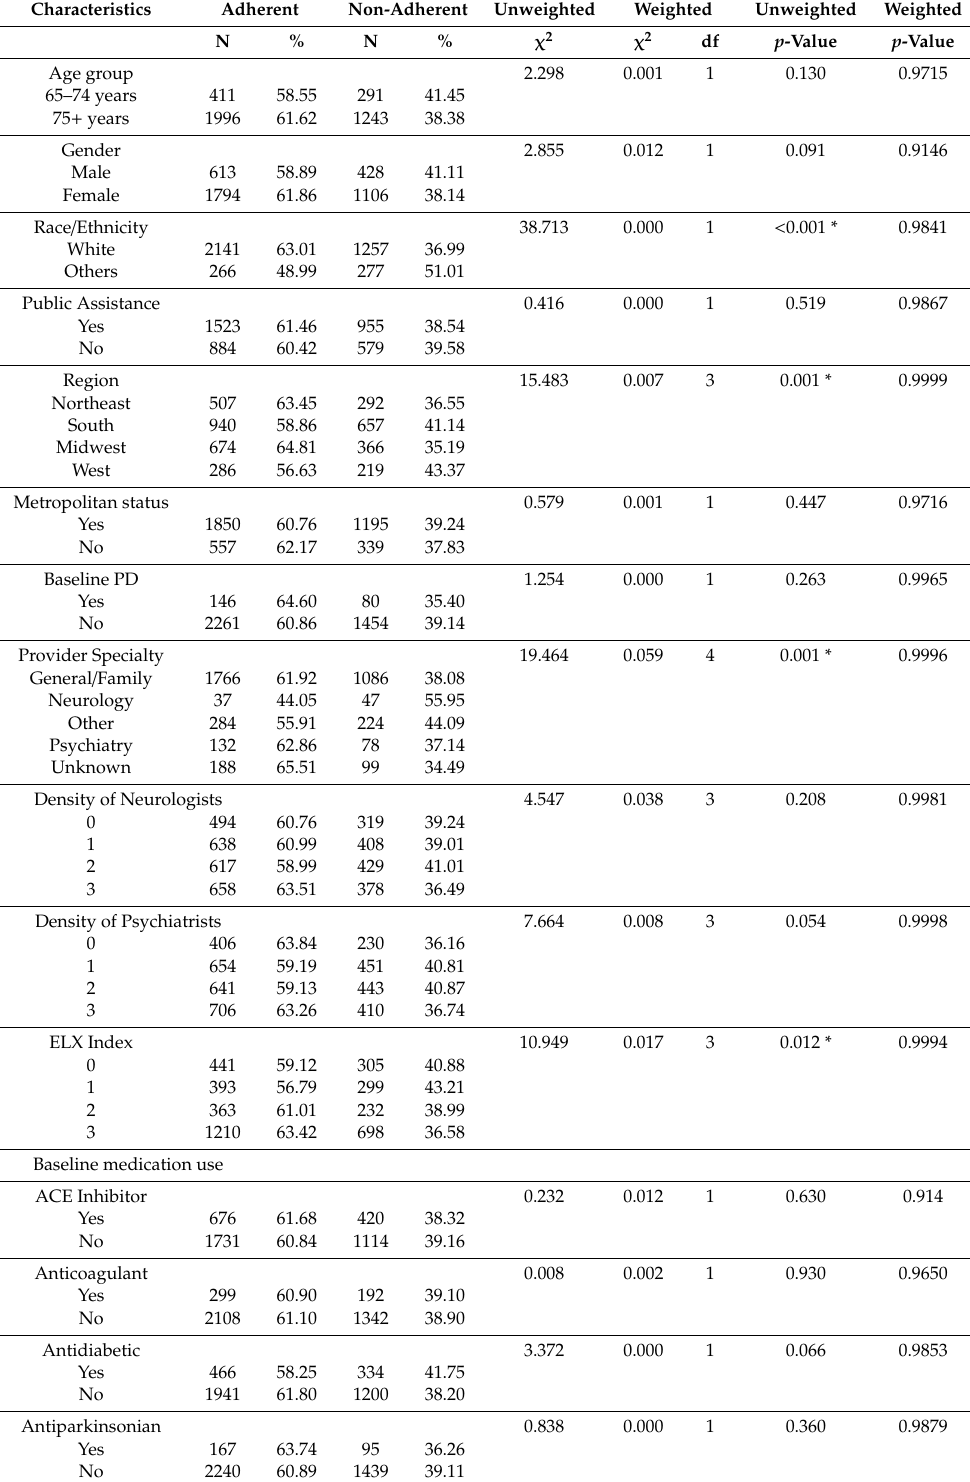
Table 2. Baseline characteristics of study sample included in the continuation depression treatment